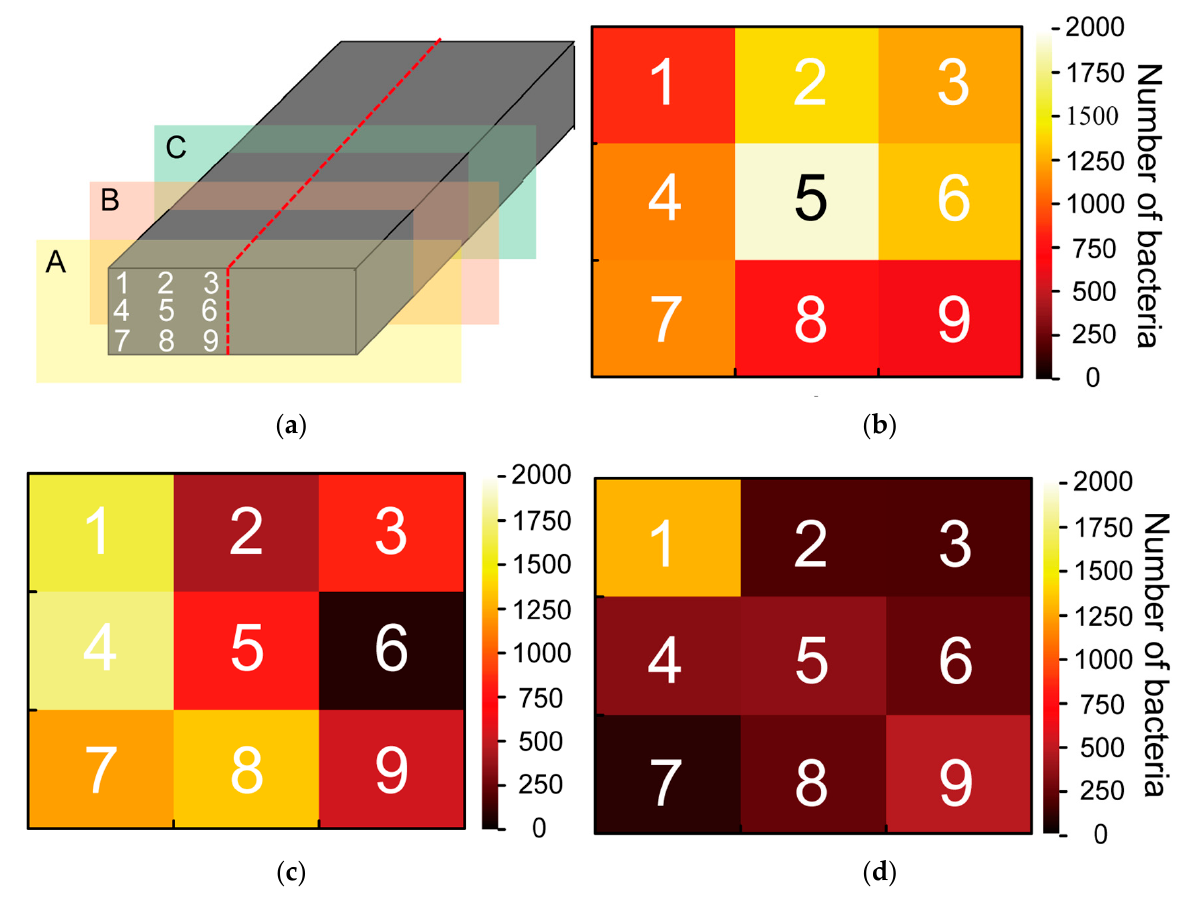
Figure 10. Evaluation results of the number of bacteria on the bamboo charcoal electrode: ( a ) the observation point; ( b ) the surface of the bamboo charcoal electrode (cross-section A); ( c ) 2nd cross- section of the bamboo charcoal electrode (cross-section B); and ( d ) interior of the bamboo charcoal electrode (cross-section C).